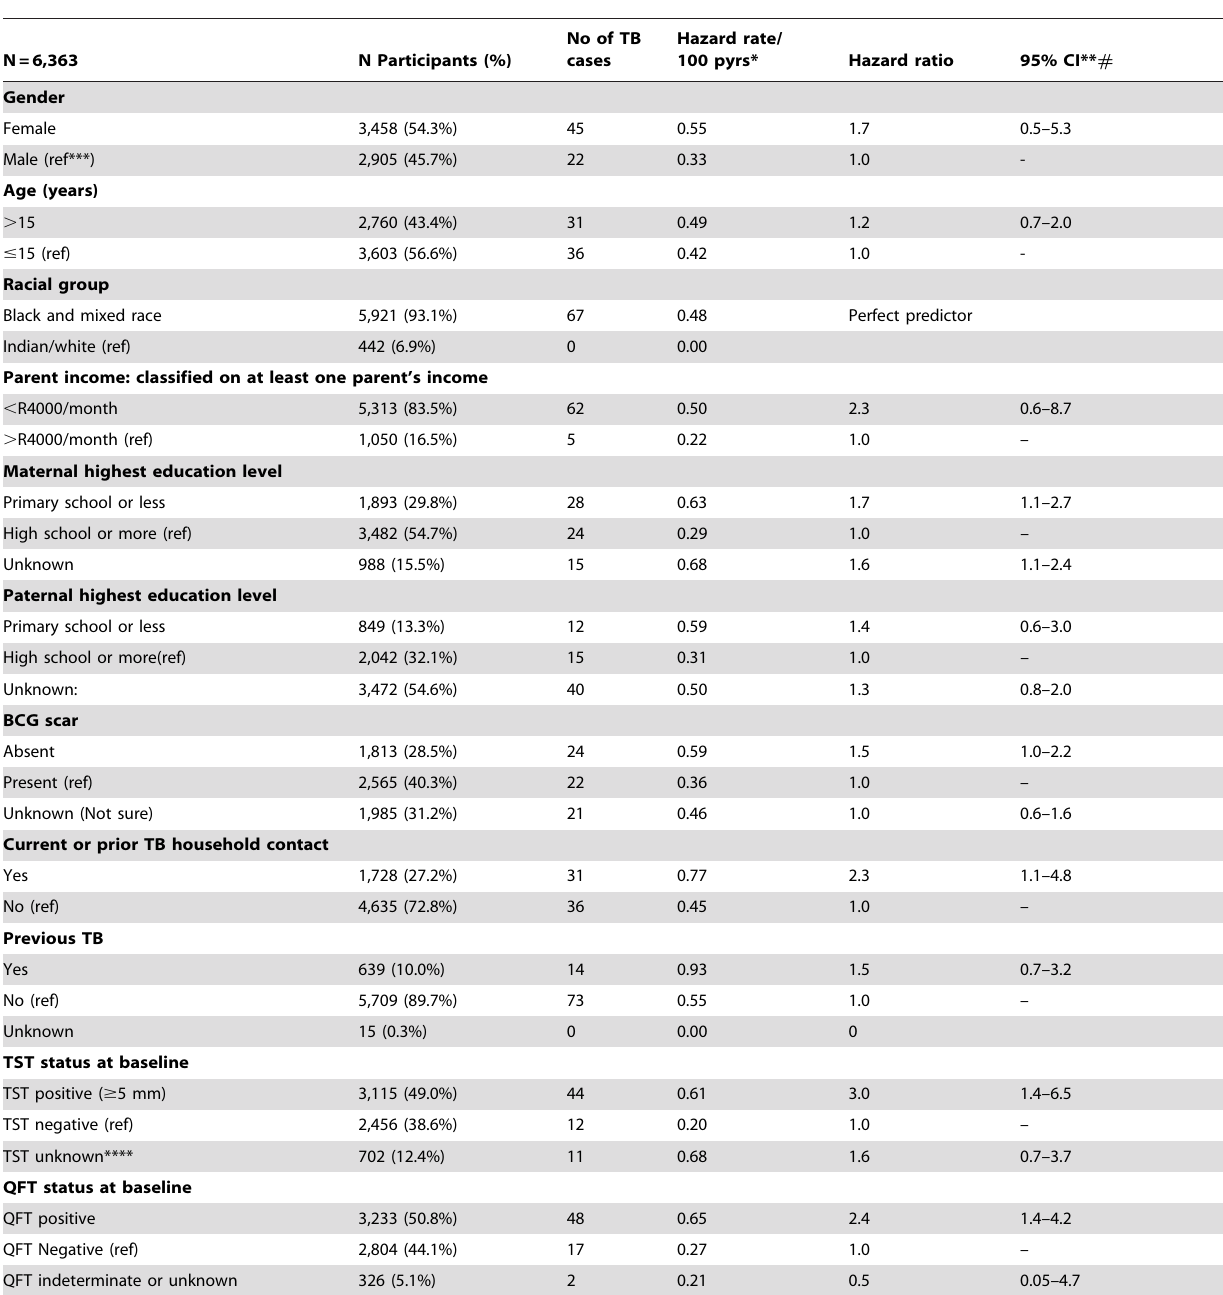
Table 1. Unadjusted analysis of risk factors for TB disease for bacteriologically confirmed TB